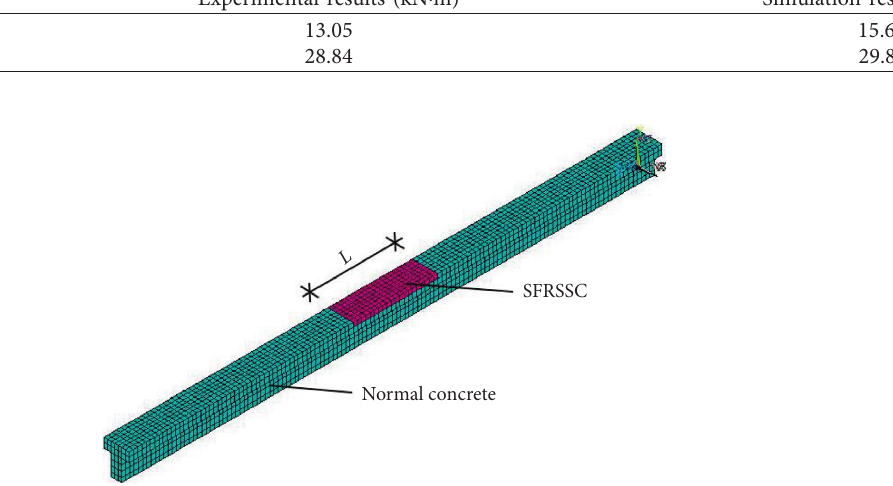
Figure 33: Model of condition II.